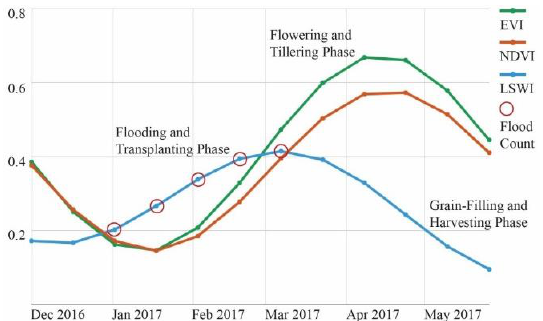
Figure 2. Rice phenology for the boro season with a flood signature of ‘5’ for